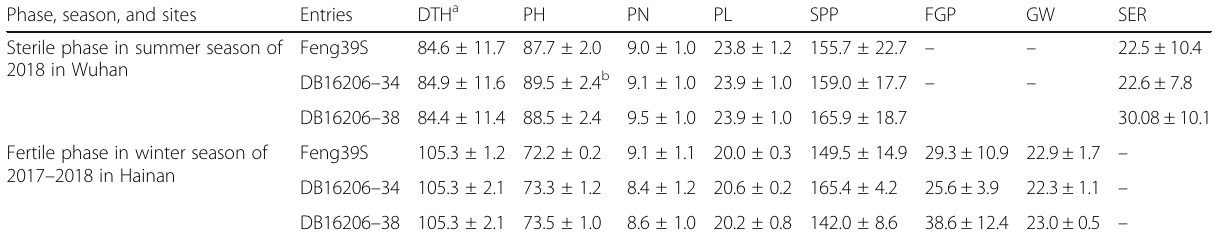
Table 5 Agronomic performance of selected PTGMS lines and recurrent parent Feng39S Phase, season, and sites